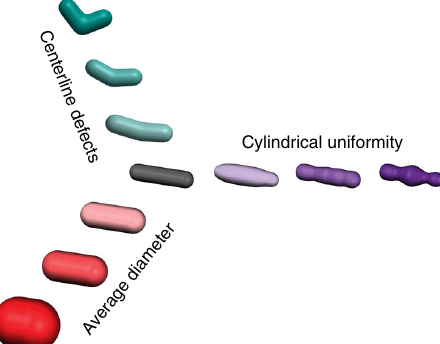
Fig. 5 Simple, straight, rod-like cell shapes require multiple parameters to describe them. A straight rod is de fi ned by its centerline curvature, cylindrical uniformity, and diameter. Deviations in any of these properties result in non-straight rods in extreme cases, and qualitatively ambiguous rods when only small changes occur. Teal — as centerline defects increase in magnitude cells become more bent until they are no longer straight. Purple — as cylindrical uniformity decreases cells exhibit increase fl uctuations in their diameter along the long axis. Red — as width increases cells become more sphere like and less rod-like. For each of these shape descriptors, a quantitative metric of shape provides a continuous rather than a binary description of rod vs.